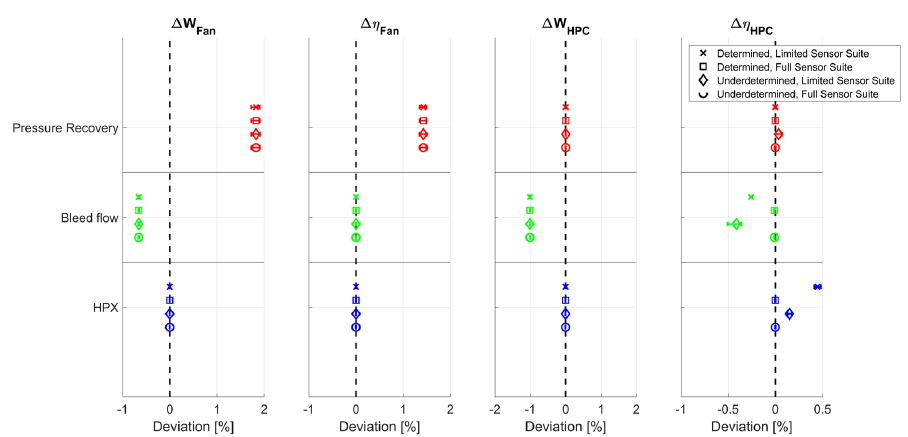
Figure 9. Fan and compressor sensitivity to erroneous installation effects.